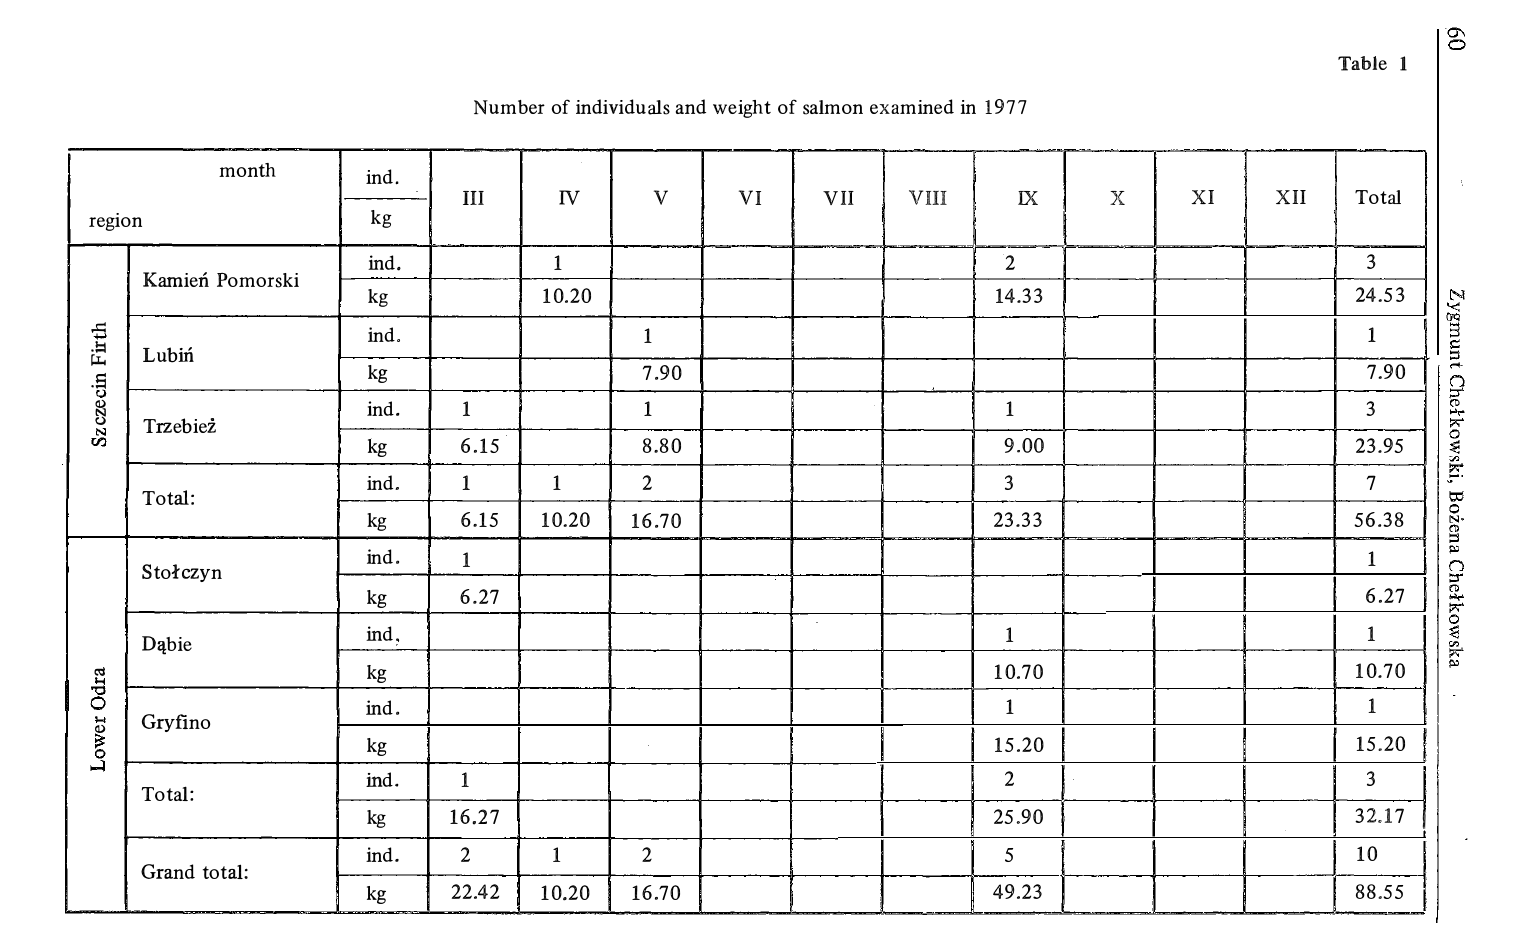
Number of individuals and weight of salmon examined in